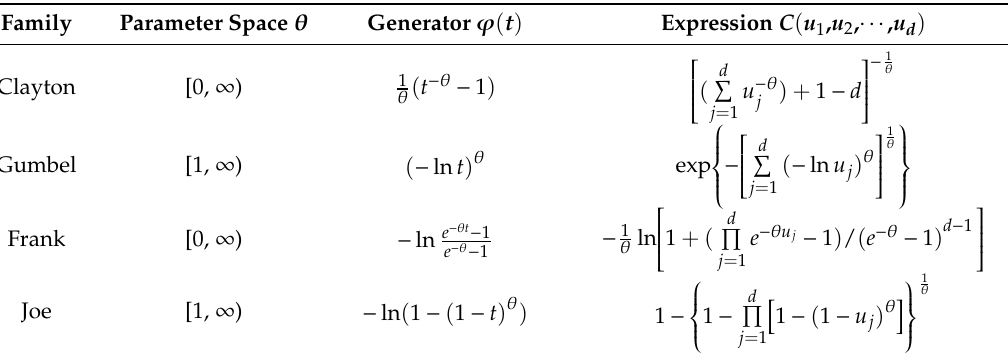
Table 2. Function expressions of Archimedean